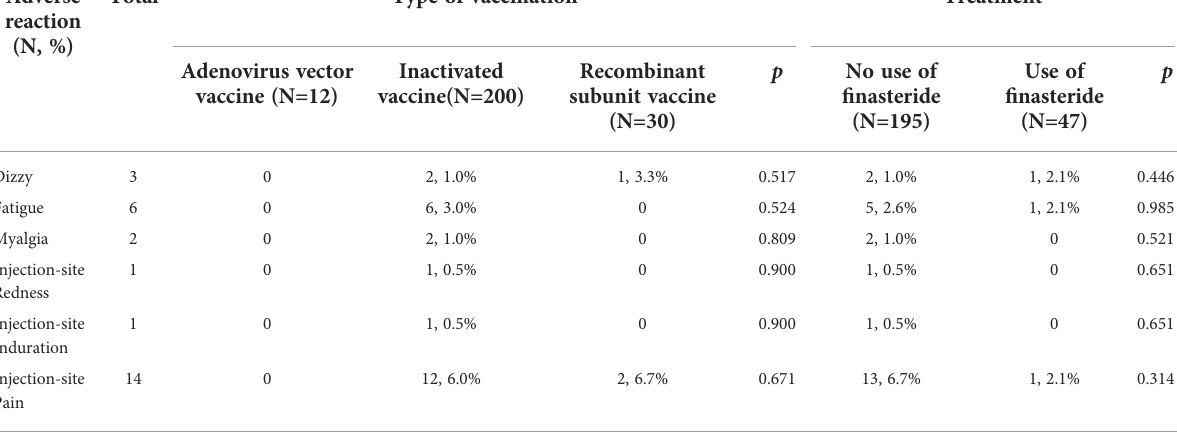
TABLE 4 Adverse reactions of vaccination by the vaccine types and the treatment among BPH patients (N=242). Adverse reaction